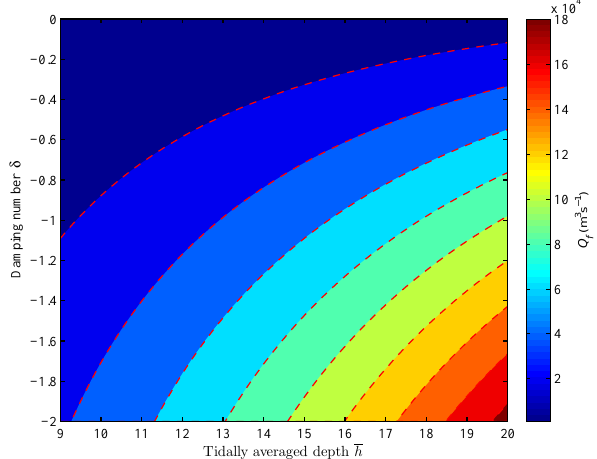
Figure 13. Contour plot of the predicted fresh water discharge at x = 456km as a function of the tidally averaged depth h and the damping number δ for given tidal amplitude η = 0.14m, con- vergence length a = 432km, Manning–Strickler friction coefficient K = 60m 1 / 3 s − 1 and storage width ratio r S =